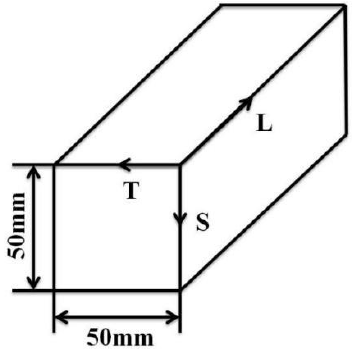
Figure 1. Sampling direction of the test specimen.